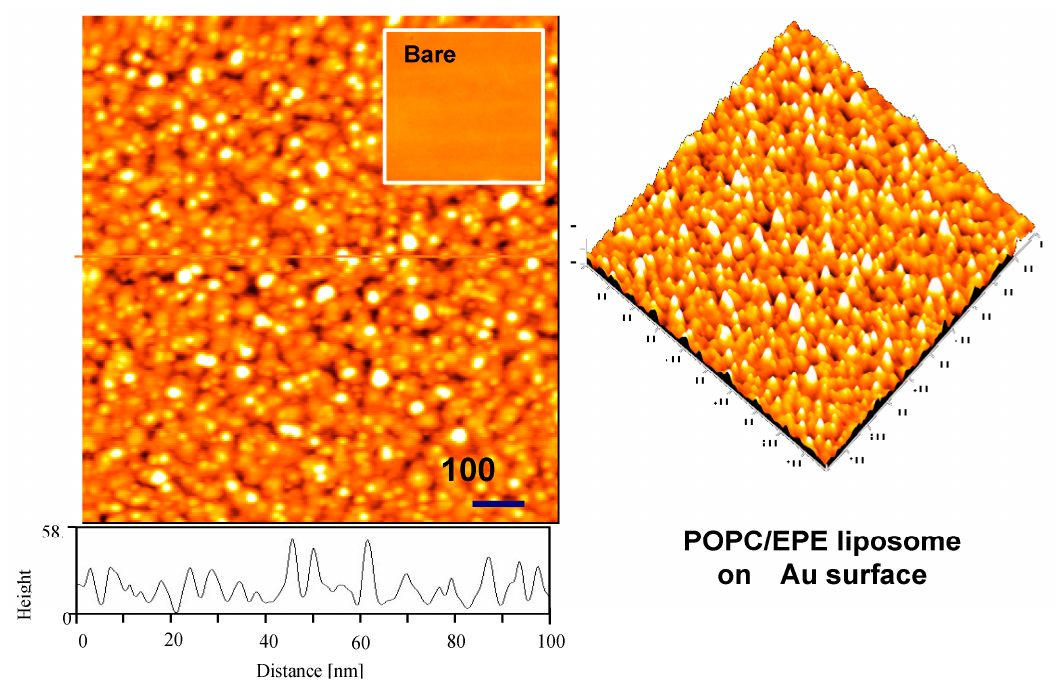
Figure 1. TM-AFM topographic images of immobilized liposome layer on Au electrode surface which was treated with self-assembly layer (SAMs) of HSCH 2 (CH 2 ) 14 COOH for amino coupling conjugation between liposome and SAMs. The bare Au electrode surface are shown in the inset.